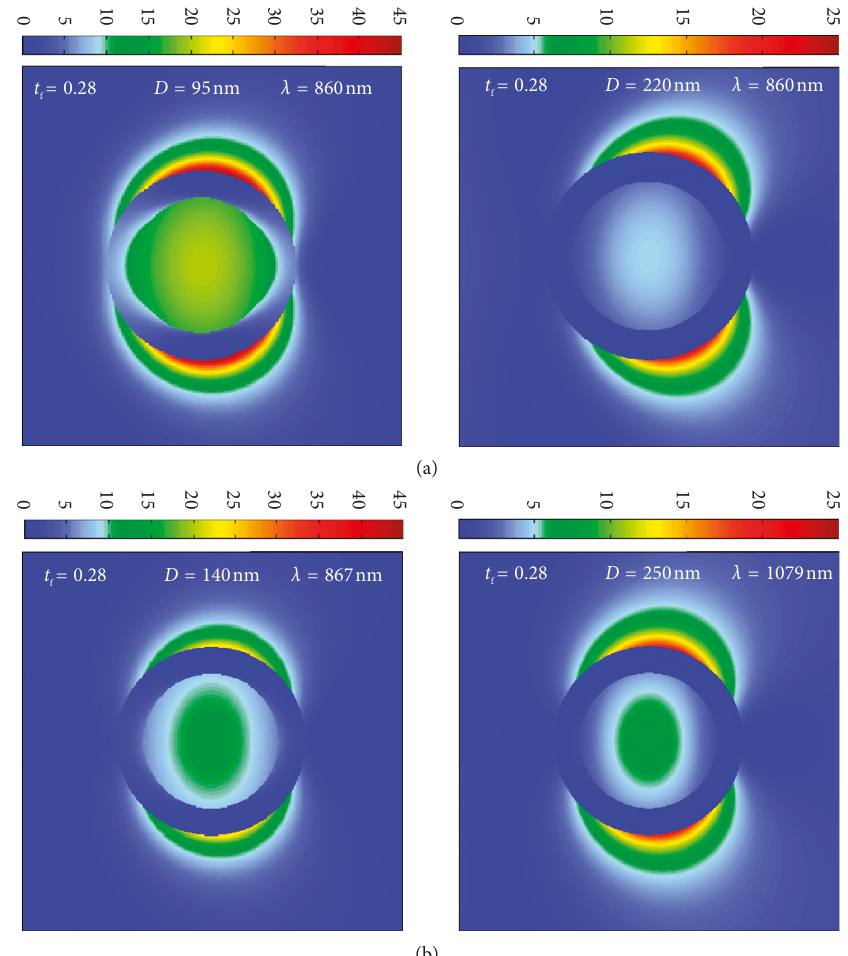
Figure 5: The spatial distribution in the xoz plane of the relative intensity of the electric field (| E | 2 / | E corresponding to relevant absorption and scattering resonances supported by a single Si/Au nanoshell in biological tissues (a) and in vacuum